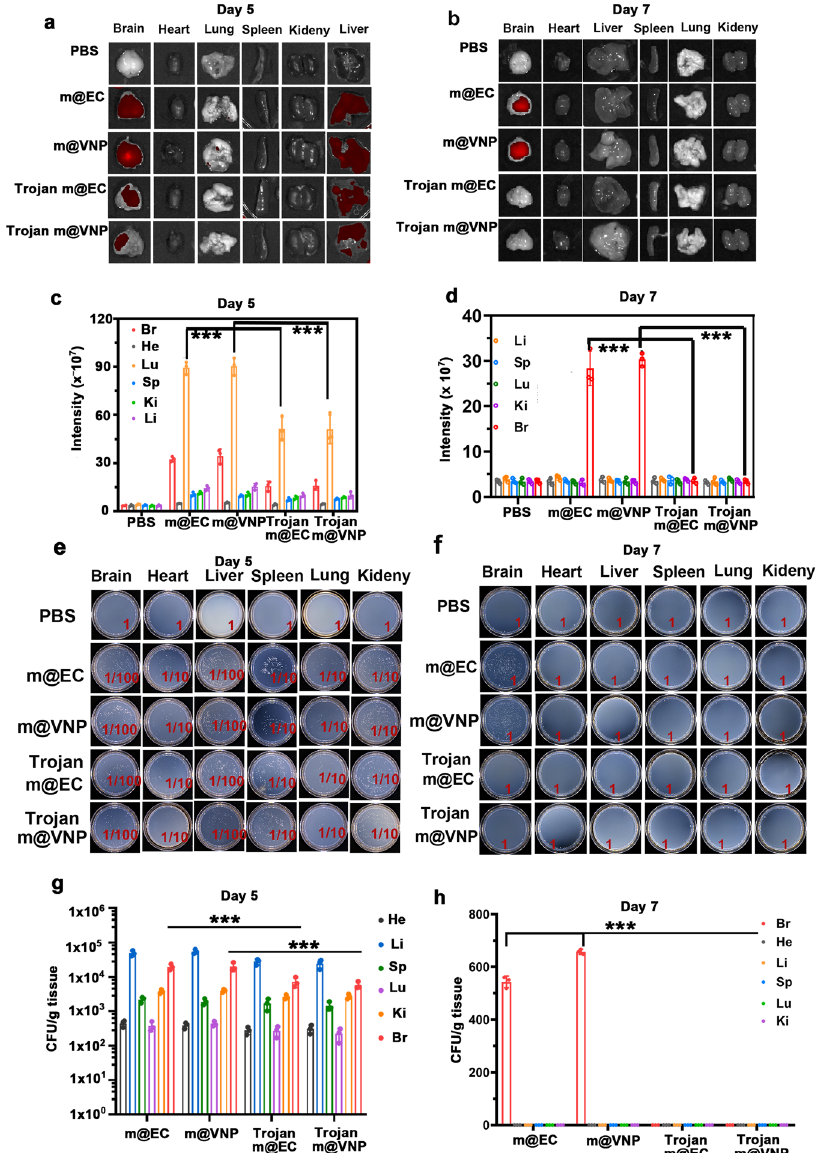
Fig. 7 | The elimination of residual bacteria after photothermal immunother- apy. The fl uorescence distribution in the main organs (heart, liver, spleen, lung, kidney, and brain) of GBM-bearing mice after 5 days ( a ) or 7 days ( b ) of photo- thermal immunotherapy. The mice were intravenously injected with PBS, ~1×10